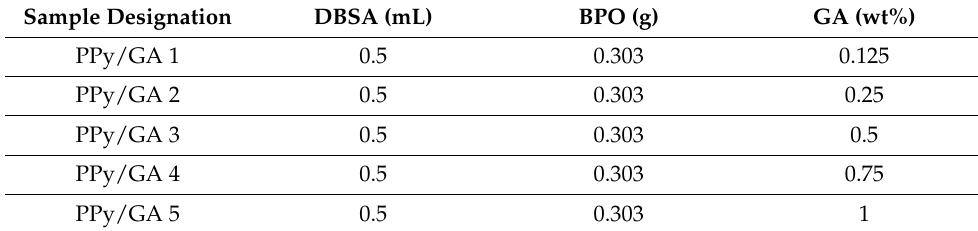
Table 1. The designation and composition of the PPy/GA composites.